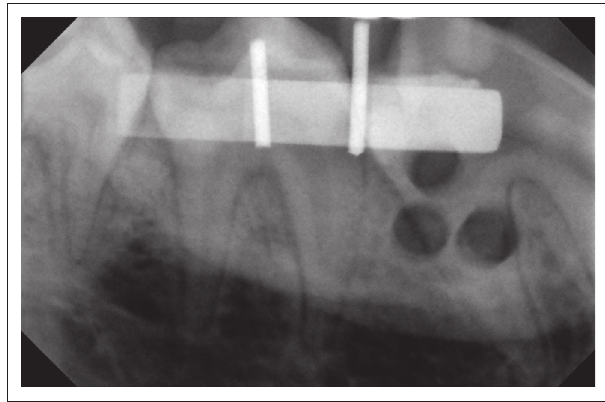
FIGURE 2: Directly post-operatively radiograph of right mandible with the three bony defects